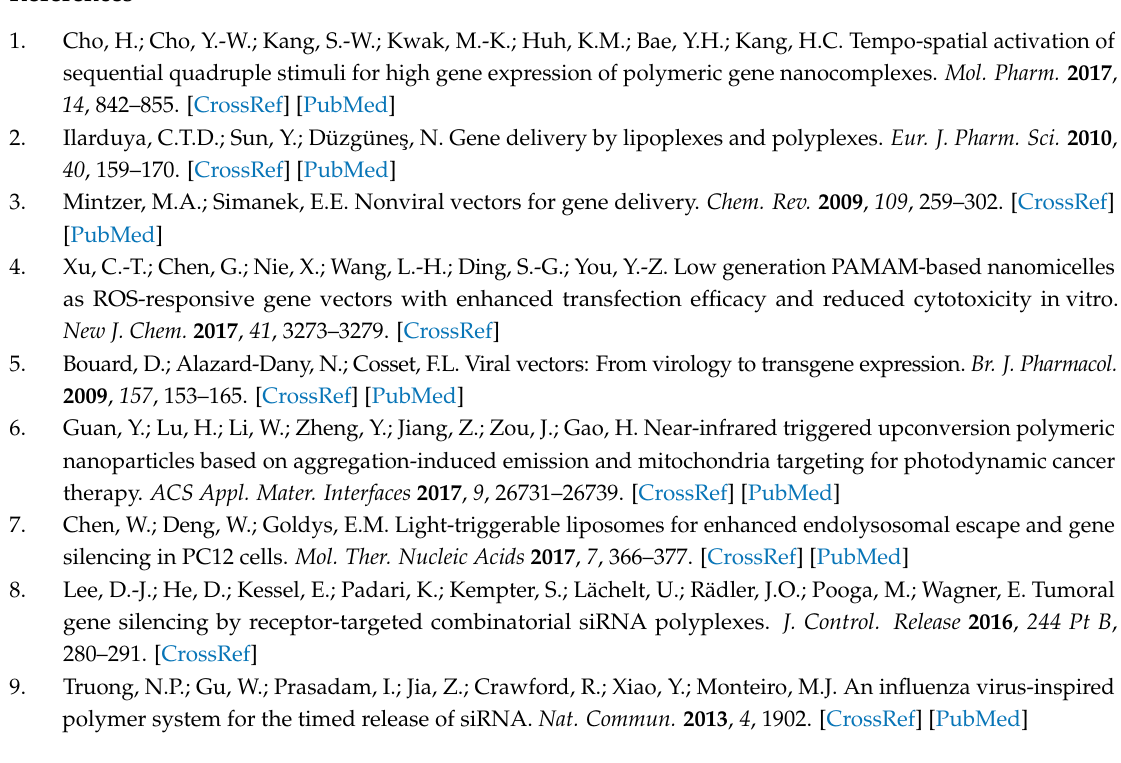
Supplementary Materials: The following are available online. Figure S1–S3 and Table S1. Additionally, 1 H, 19 F and 13 C-NMR and GPC data for the compounds are